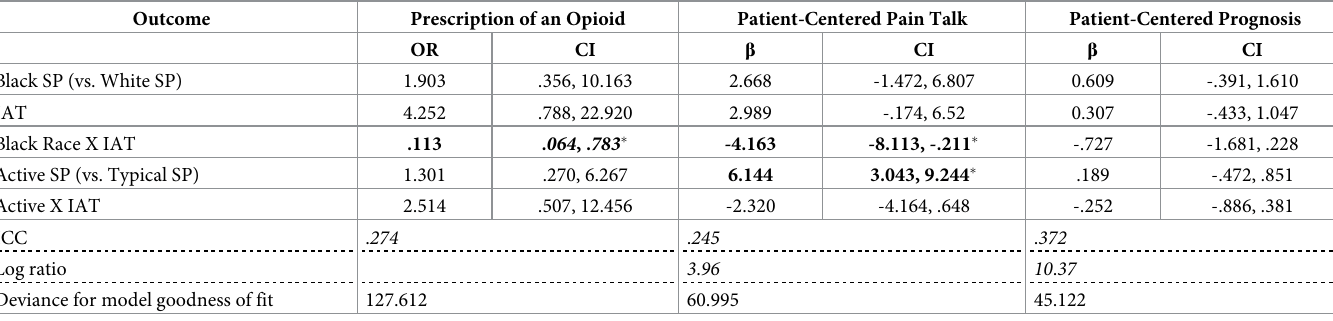
Table 2b. Patient care outcomes: SP race, IAT, and interaction of race and IAT 1 . Outcome Black SP (vs. White